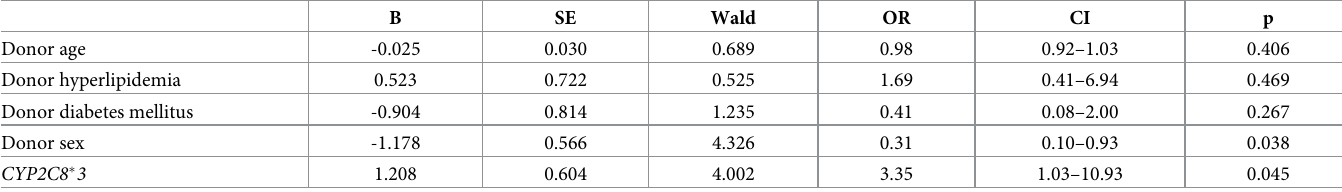
B, regression coefficient; SE, standard error; OR, odds ratio; CI, 95% confidence interval